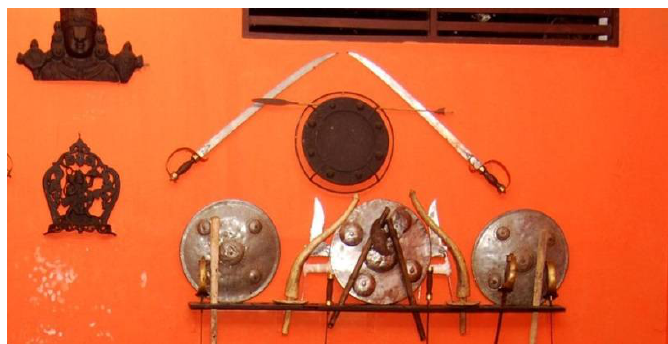
Figure A2. The weapons in CVN Ka ḷ ari Nadakkavu (author).